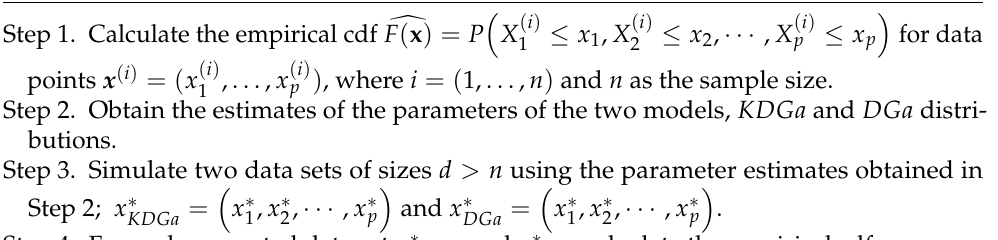
Algorithm 2 Computing the KS ratio measure.